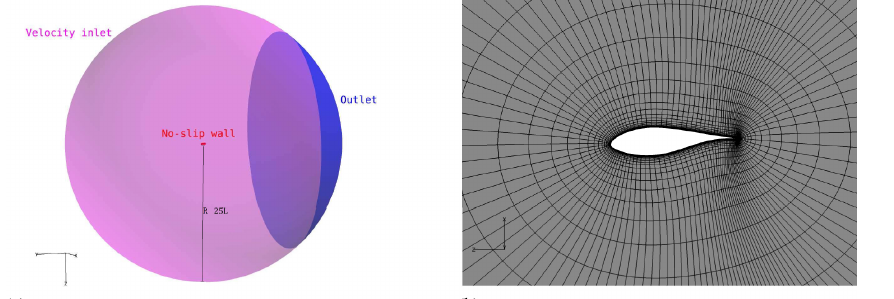
Figure 5. Spherical grid configuration: (a) outer boundary of grid and (b) extruded grid around airfoil. Only every second line is shown for visual